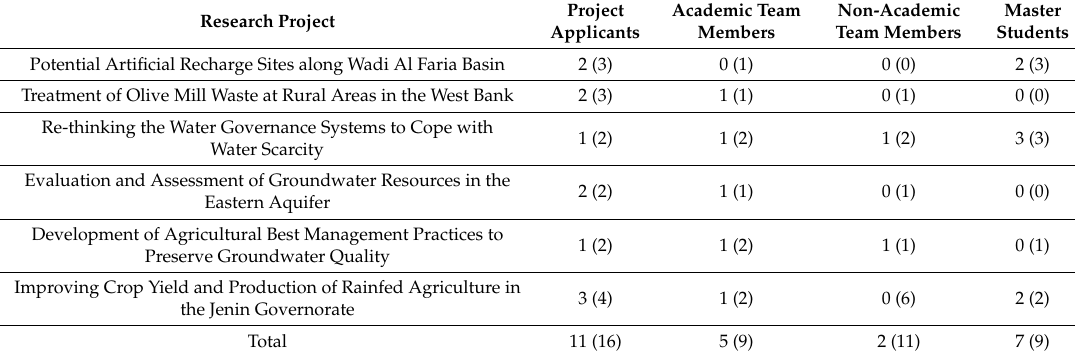
Table 5. Representation of the different roles within the project teams (Numbers indicate the actual respondents in each category, with the number of potential respondents in